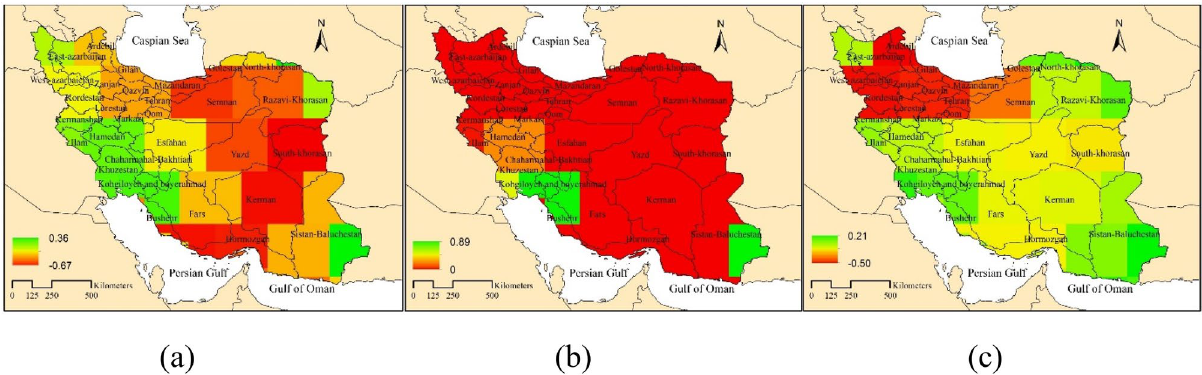
Figure 5. Time Series Trend of EWH anomaly Using the Man-Kendall test ( a ), P value ( b ), Theil-Sen slope ( c ).